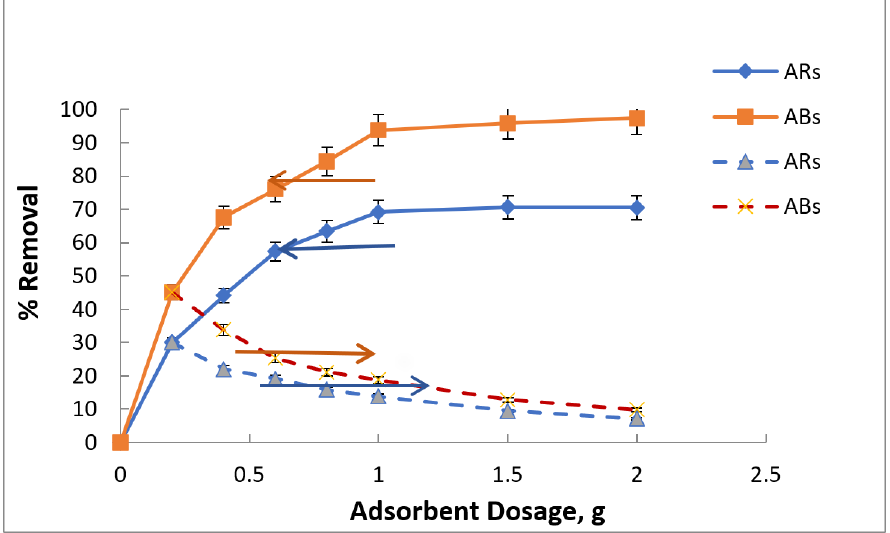
Figure 11. The impact of adsorbent dosage on the adsorption of oil onto adsorbent (400 mg/L oil– water solution, pH 6.5, Temp. 25 °C, 60 min).